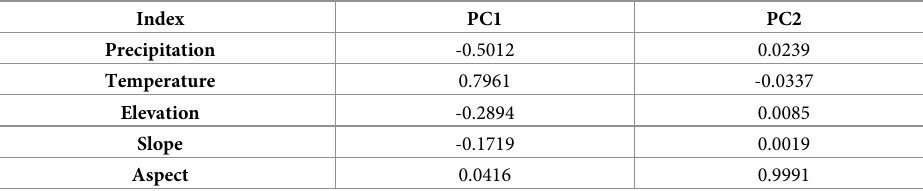
Table 2. The loading status of the factor to the original